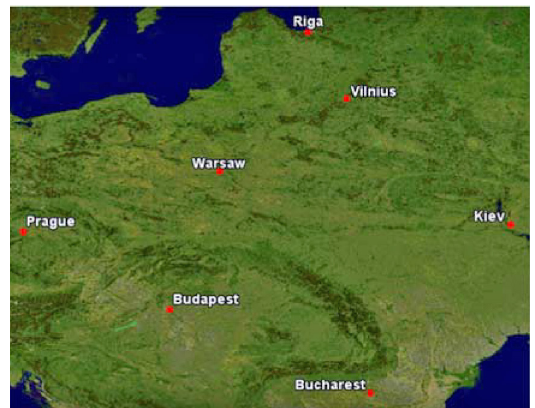
Fig. 1. Airports included in the route study on the Great-circle mapper